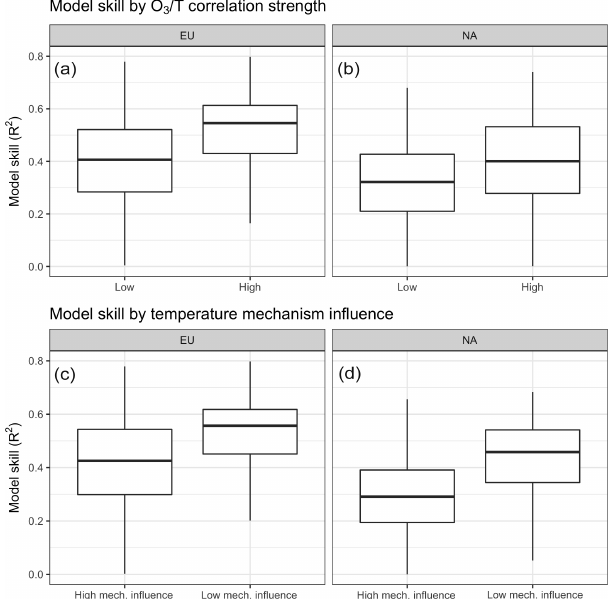
Figure 10. Differences in model skill compared to surface station observations as a function of overall O 3 –temperature correlation (a, b) and the relative importance of modeled temperature-dependent mechanisms (c, d)